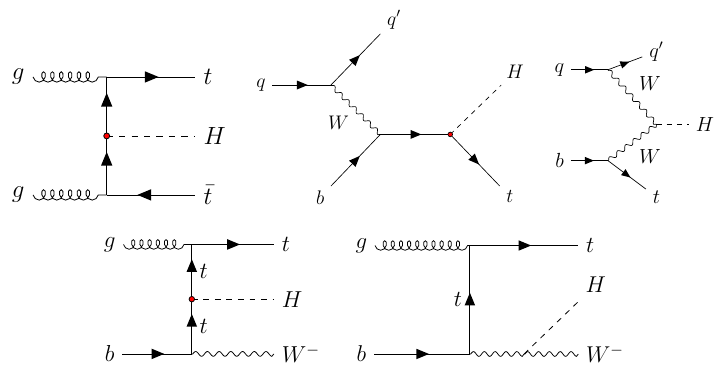
Figure 1 . Exemplary Feynman diagrams for the t ¯ tH (upper left diagram), tH (upper middle and right diagrams), and tWH (lower diagrams) signal processes.